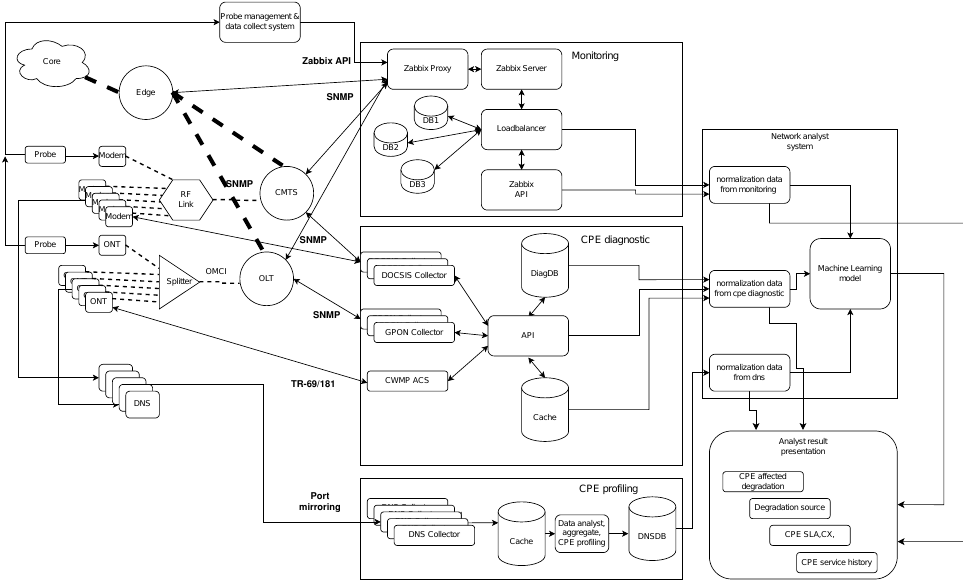
Figure 1. Data Collection